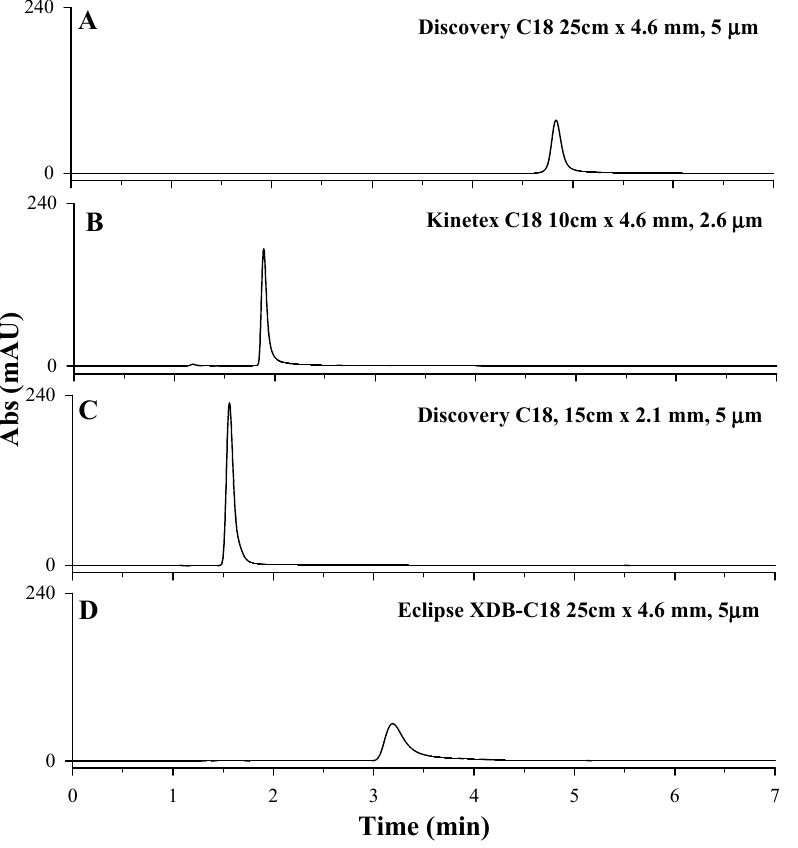
Figure 3. HPLC-UV chromatographic profiles obtained during the optimization of stationary phase: ( A ) Discovery C 18 column, 250 × 4.6 mm, 5 µm; ( B ) Kinetex C 18 column, 100 × 4.6 mm, 2.6 µm particle size; ( C ) Discovery C 18 column, 150 × 2.1 mm, 5 µm; ( D ) Agilent ZORBAX Eclipse XDB C 18 column, 250 × 4.6 mm, 5 µm. An LD standard solution at 50 mg/L solubilized in HCl 0.1 M, 97% acetic acid 0.2% v / v , and 3% methanol as mobile phase, under isocratic conditions depending on the tested C 18 column (1 mL/min for Discovery C18 column, 0.8 mL/min for Kinetex C18 column and Agilent ZORBAX Eclipse XDB, 0.5 mL/min for Discovery Supelco C18 column.), injection volume of 20 µL and λ max set of 280 nm, were used.